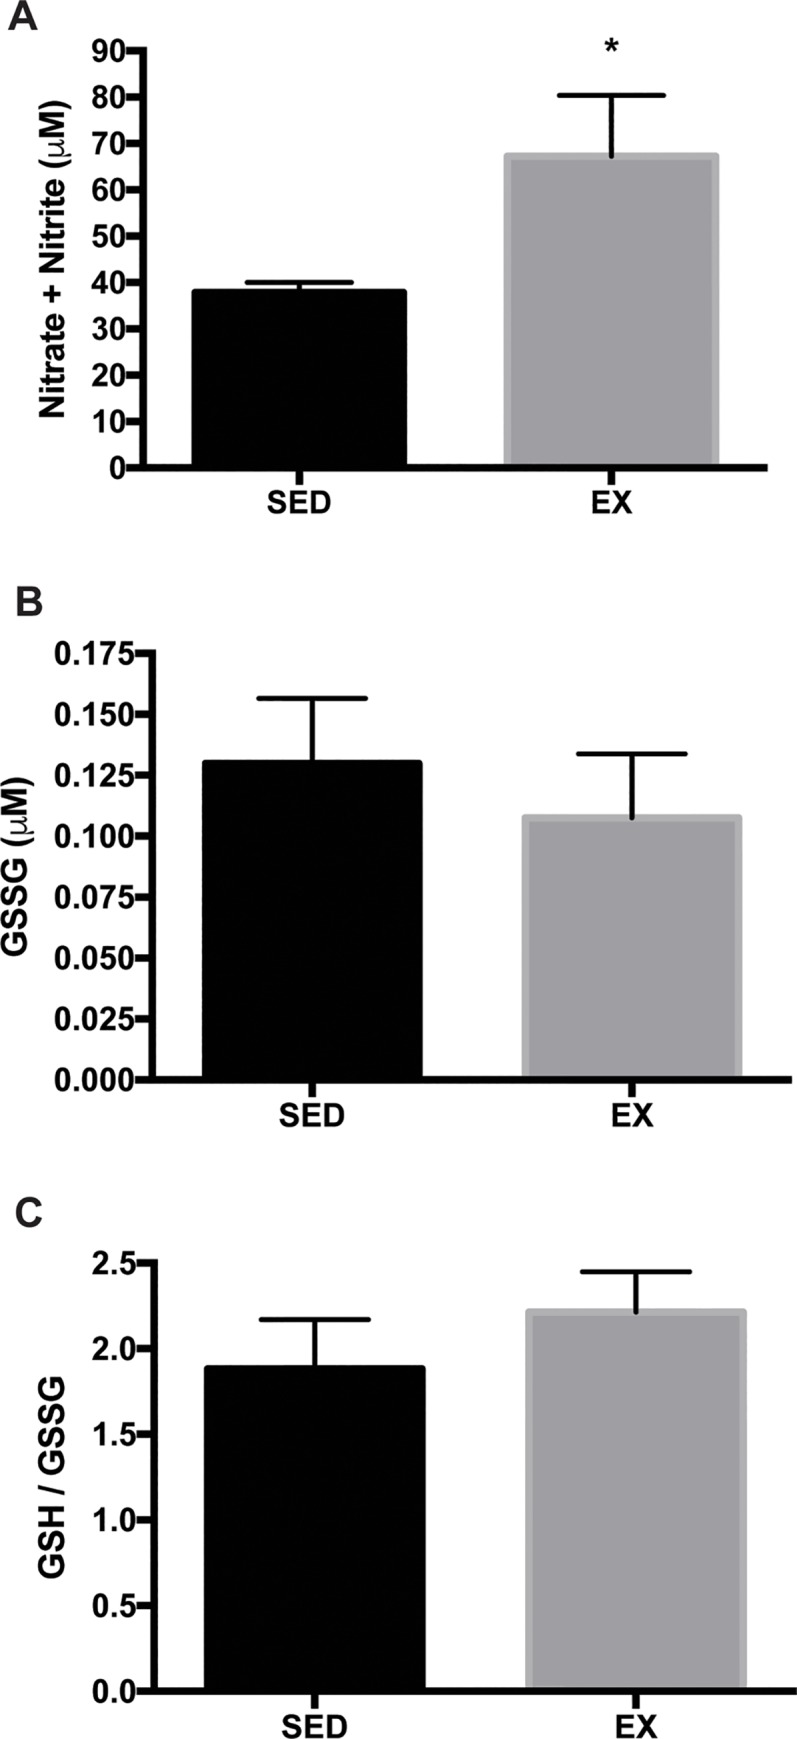
Levels of plasma NO and oxidized glutathione.A. Hemoglobin-free plasma was used to determine total nitrate and nitrite levels (n = 8 per group). *p<0.05. B. Metaphosphoric acid (5%)-treated plasma was used to determine oxidized glutathione levels and GSH/GSSG ratio (n = 17 per group).